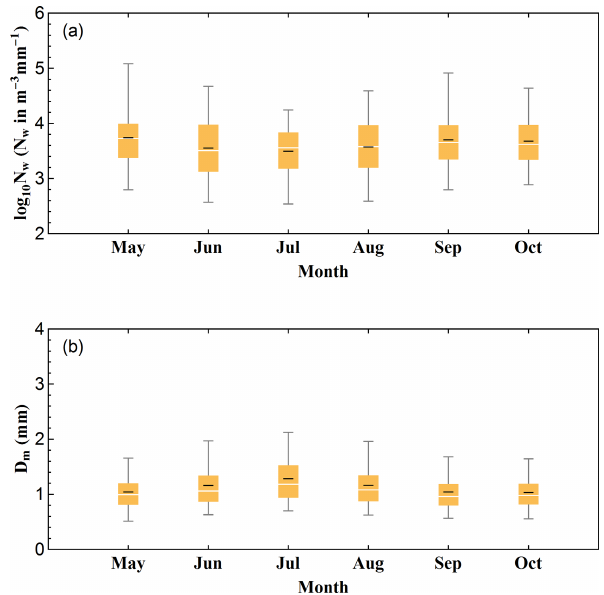
Figure 12. Same as Fig. 8 but for different months.